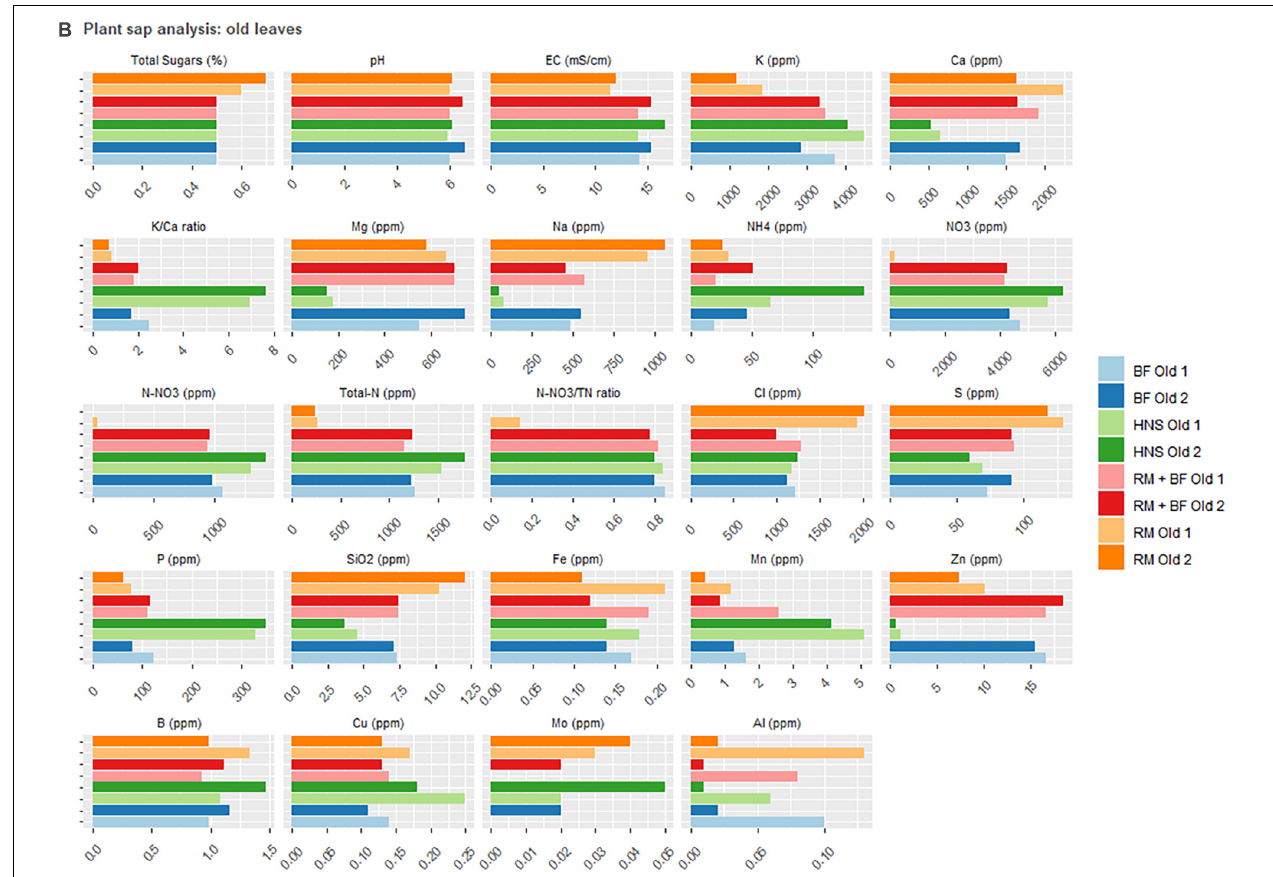
FIGURE 8 | Plant sap analysis for young (A) and old (B) leaves collected 2 weeks prior to harvest and at the harvest.